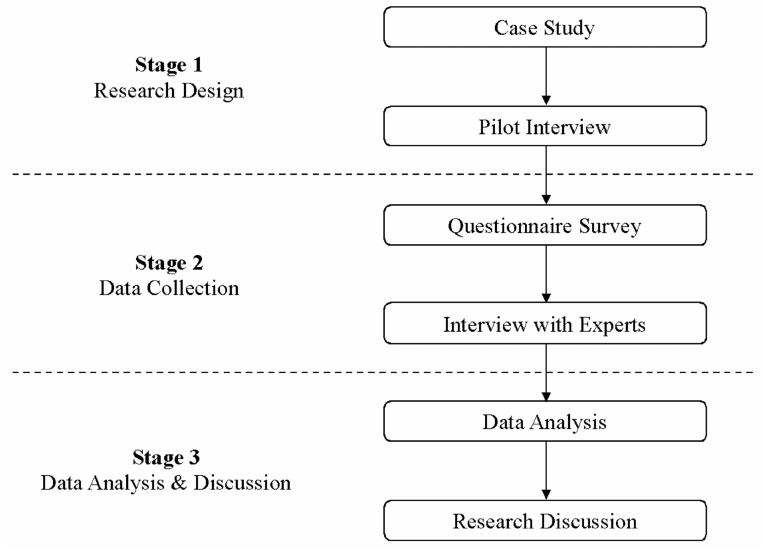
Figure 1. Research flow